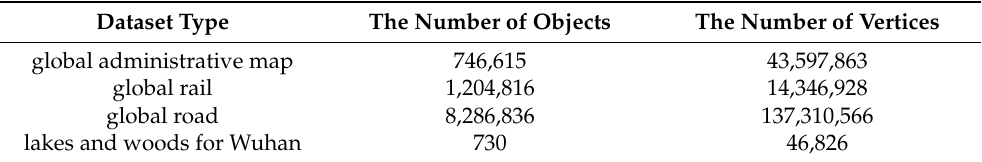
Table 1. Tested vector